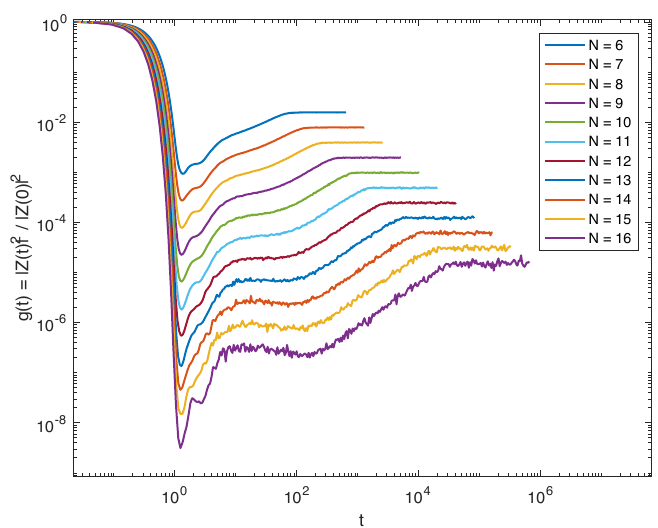
Figure 10 . The spectral form factor for the local randomly coupled qubits (Local-RCQ) with 8 to 16 qubits. We observe universal behavior of g ( t ); Gaussian decay at the early times, follow by an intermediate region, then a ramp and plateau. The time scale where the intermediate region ends and the ramp starts we will call the ‘ramp